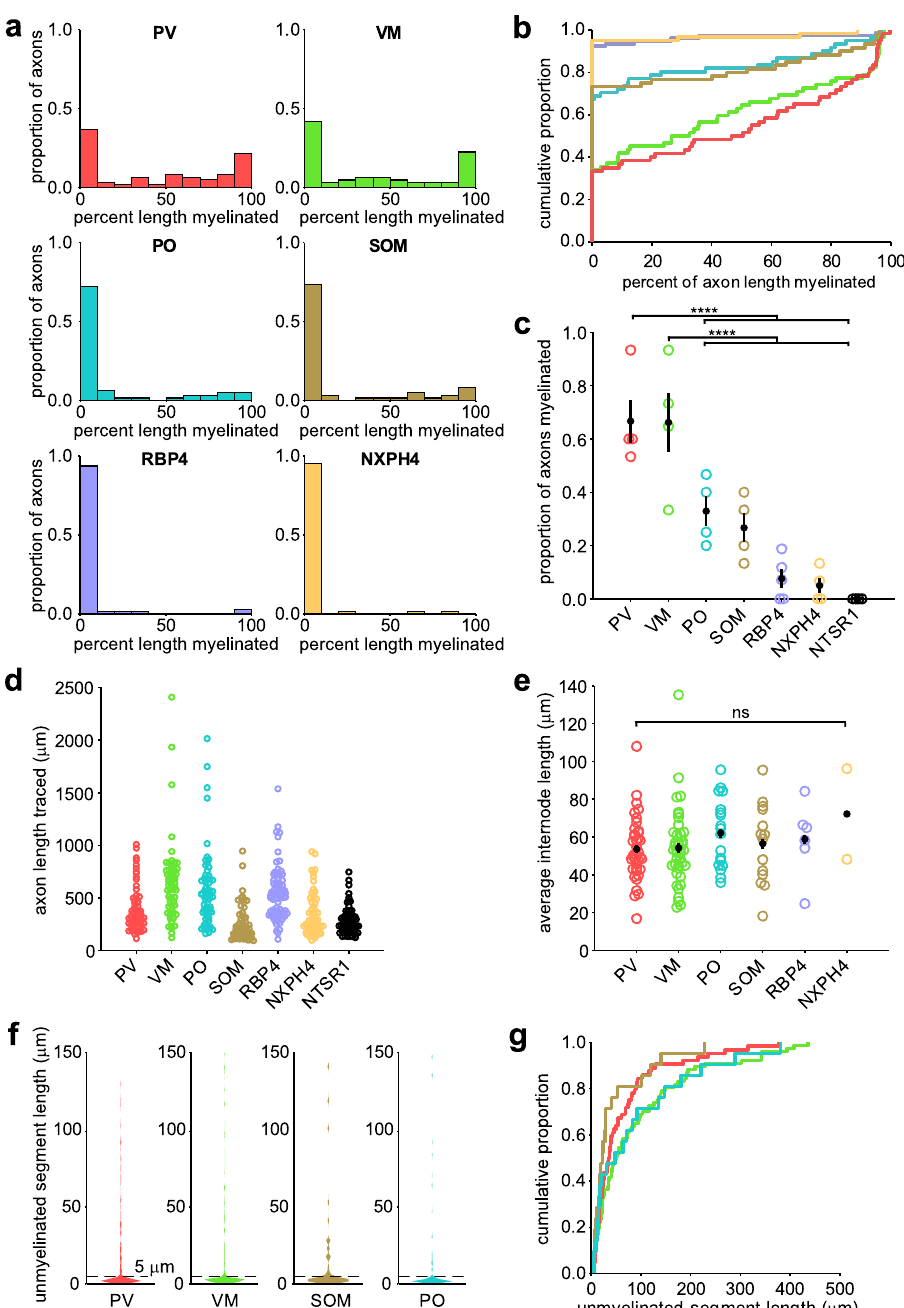
Fig. 2 Different neuronal subtypes exhibit diverse myelination pro fi les. a Myelination pro fi les for the six neuronal subtypes examined in this study with myelinated axons. Each plot is a histogram of pooled data across four animals for each subtype representing the proportion of axons with different percent length myelinated in 10% bins ( n = 60 (PV), 62 (VM), 60 (SOM), 61 (PO), 60 (NXPH4), 78 (RBP4), 60 (NTSR1) axons). See Table 2 for statistical comparisons. b Cumulative distribution plot of data in ( a ), showing three distinct classes of myelination patterns. c Proportions of axons myelinated per neuronal subtype ( N = 4 mice for each subtype) **** p < 0.0001. d Lengths for each axon traced (same N s as in ( a )). e Average internode lengths per axon for each neuronal subtype ( n = 38 (PV), 41 (VM), 18 (SOM), 14 (PO), 6 (NXPH4), 2 (NTSR1) axons) (ns, not signi fi cant, p = 0.514, one-way ANOVA). f Violin plots of the lengths of unmyelinated axon segments (axonal distance between two consecutive MBP segments) for the top four most strongly myelinated neuronal subtypes. Unmyelinated segments of <5 μ m (typical maximum length of nodes of Ranvier) are most common, while unmyelinated segments between 5 and 150 μ m distributed broadly. g Cumulative distribution plot of all non-nodal (>5 μ m) unmyelinated segments from data in f . All error bars represent the standard error of the mean. Source data and statistical tests are provided as a Source Data fi